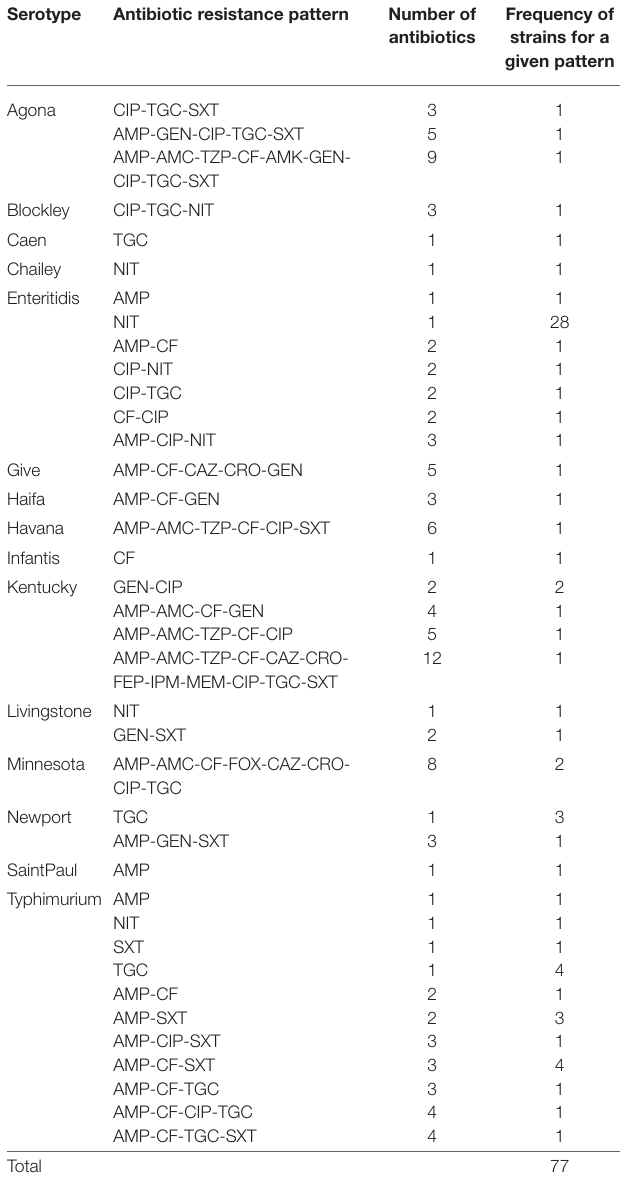
TABLE 6 | Antibiogram for Salmonella strains that are resistant to antibiotics. Serotype Antibiotic resistance pattern Number of